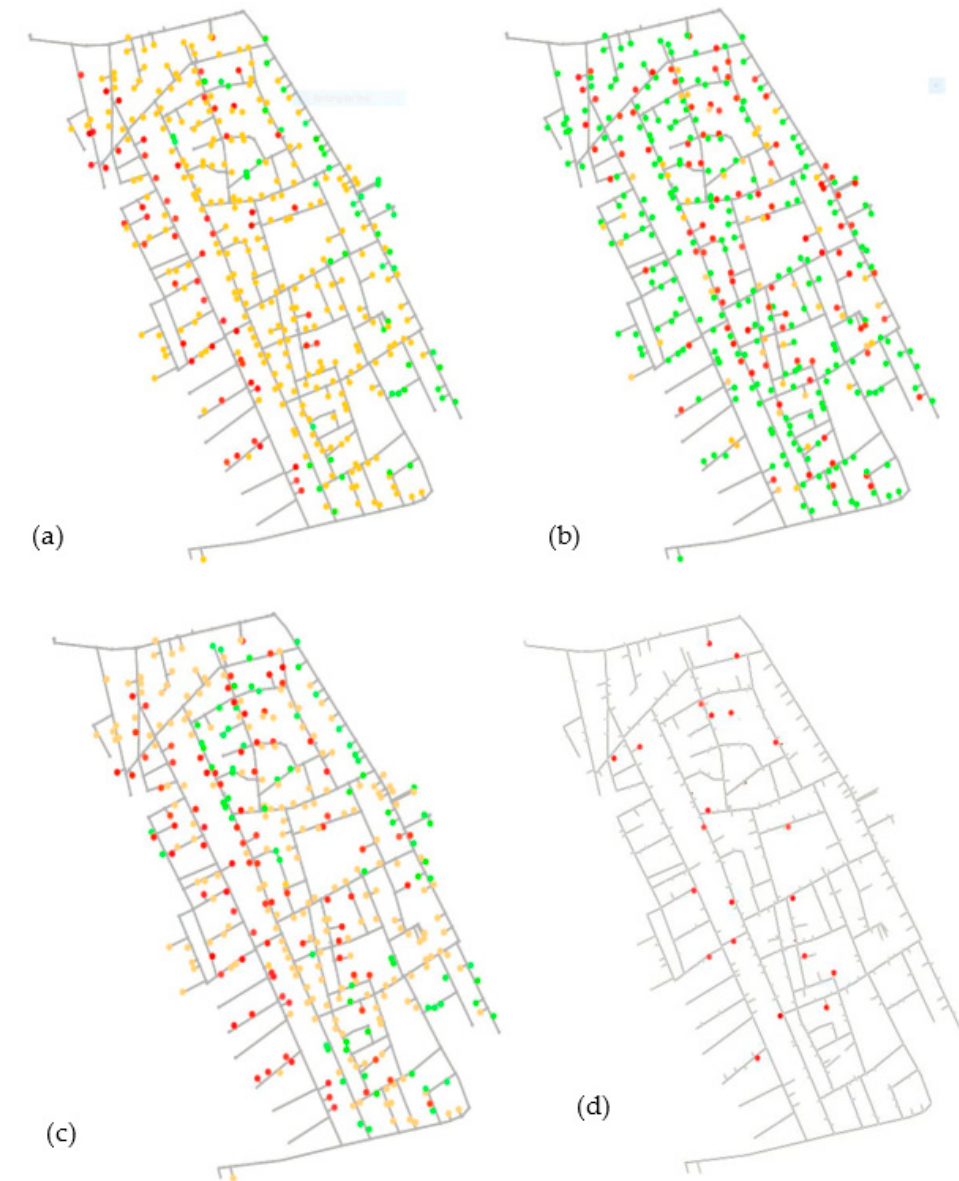
Figure 9. Spatial display of risk-based priority levels for service connections for inspection and rehabilitation of service connections, ( a ) consequence index, ( b ) vulnerability index, and ( c ) overall risk index, ( d ) model validation results, where all the 21 service connections repaired in response to customer complaints were ranked as high-risk connections by the developed model.